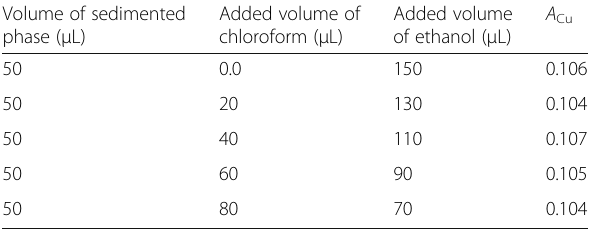
Table 2 Results of investigation of the effect of the ratio of volume of the sedimented phase to volume of ethanol (diluting solvent) on the analytical signal of Cu(II) determined by DLLME Volume of sedimented phase ( μ L)